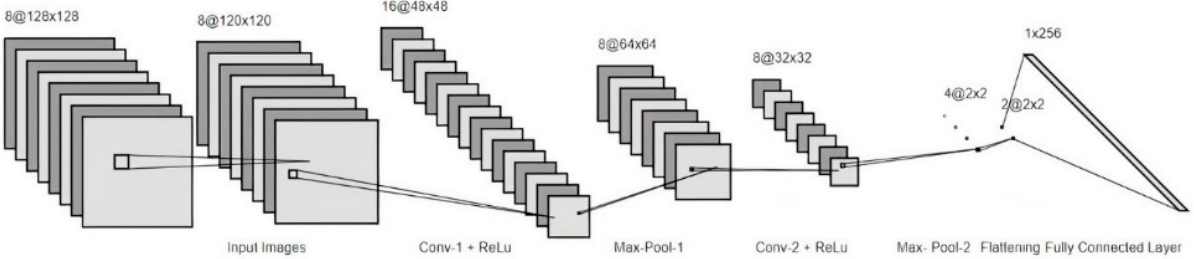
Figure 4. The convolutional architecture of the two-layered CNN model.